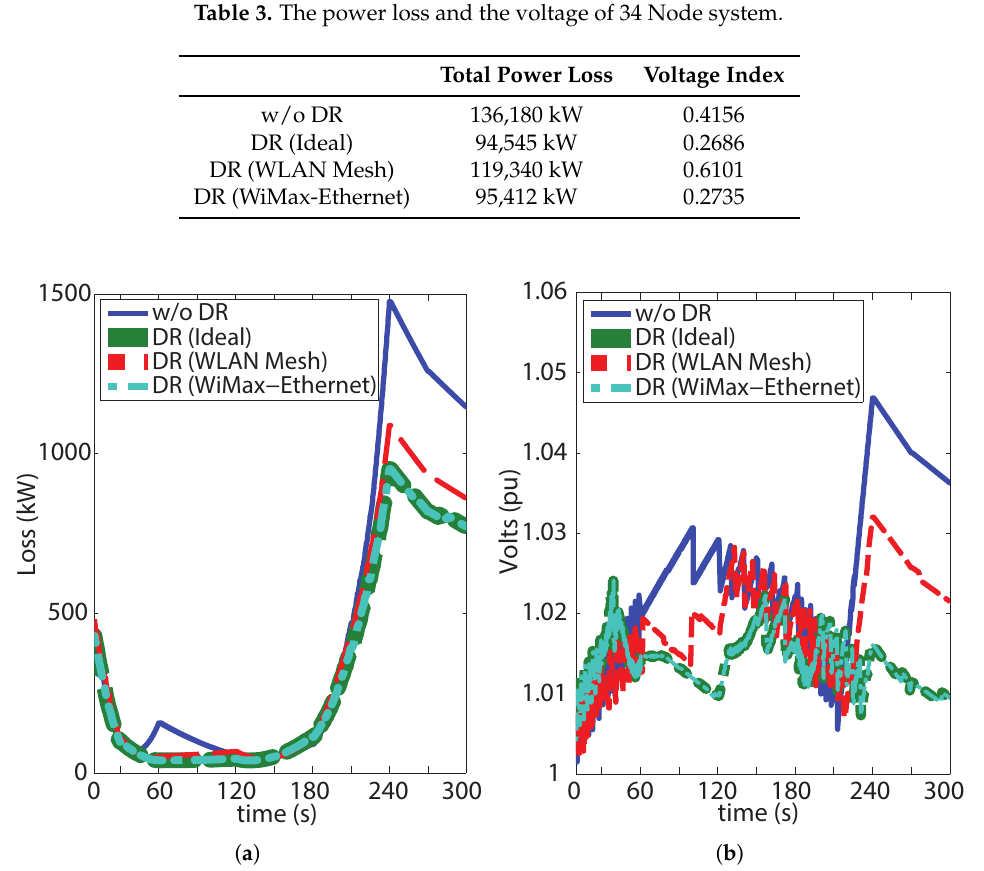
Figure 12. The power loss and the voltage of 34 Node system. ( a ) Total power loss; ( b ) Voltage of 852